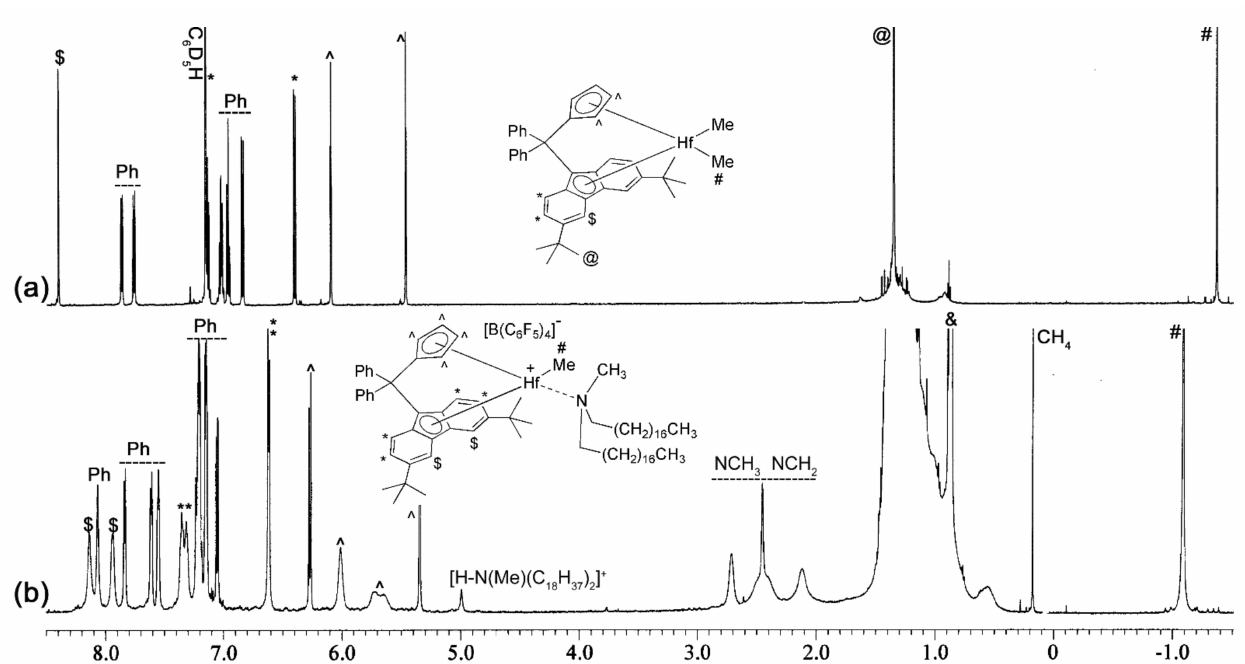
Figure 5. 1 H NMR spectra of 3 -HfMe 2 ( a ) and its activated complex [ 3 -Hf(Me)(NMe(C 18 H 37 ) 2 )] + [B(C 6 F 5 ) 4 ] − ( b ). Signals marked with $, *, ˆ, @, &, and # characters correspond to protons marked with those characters in the